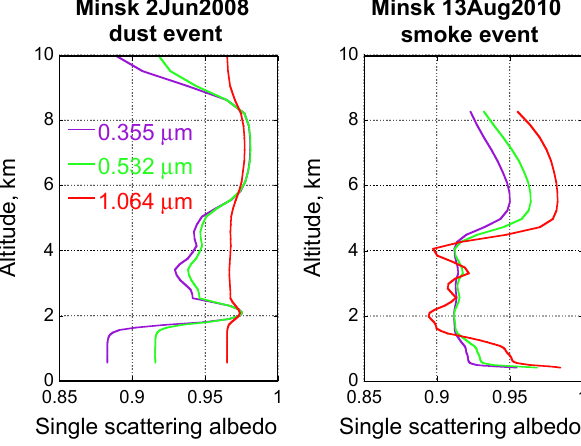
Fig. 19. Retrieved vertical profiles of aerosol single-scattering albedo.